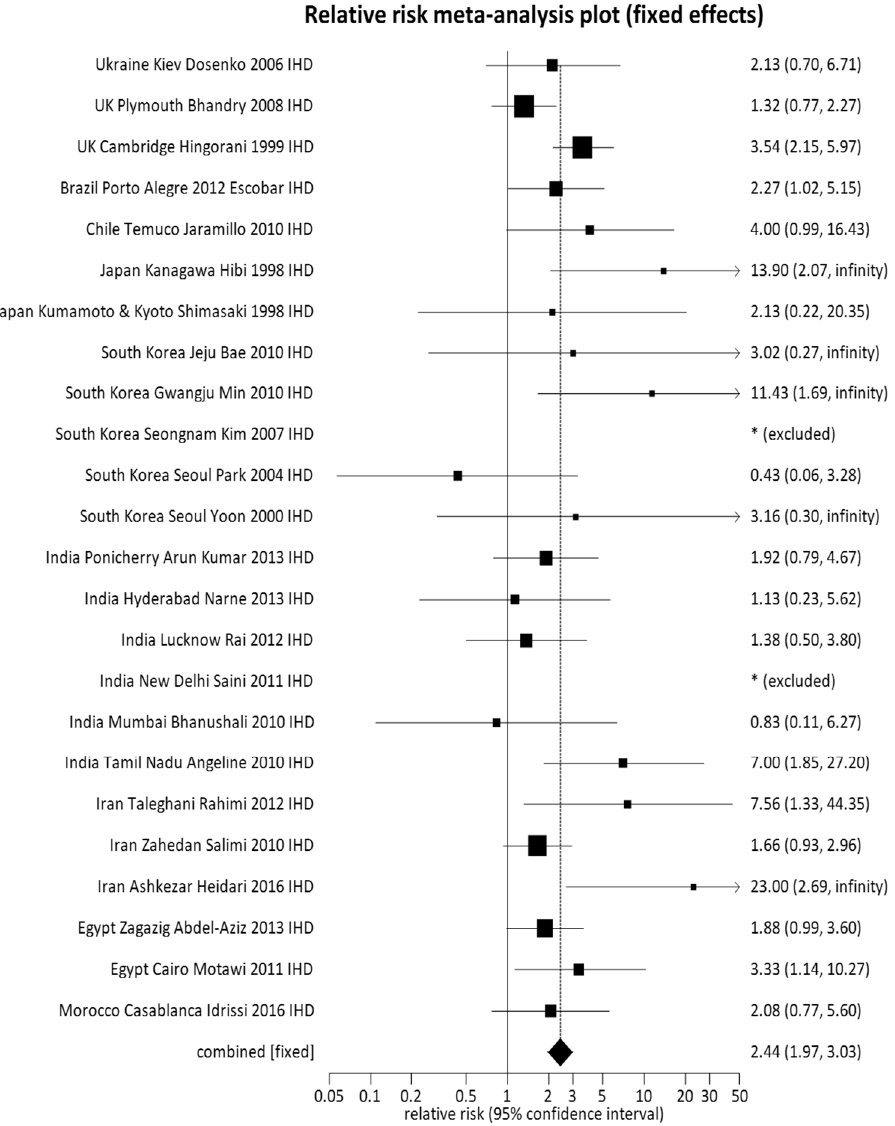
Figure 2. Forest plot for countries with pooled relative risk (RR) > 2 for the meta-analysis of the association between the NOS3 TT genotype and ischemic heart disease (IHD). The midpoint = point effect estimate for each study. The area of the box = weight given to the study. The length of the line = 95% confidence interval for the effect estimate in an individual study. The width of the diamond = 95% confidence interval for the overall effect estimate. Note * (excluded): study excluded due to no TT genotypes reported for case/control groups.